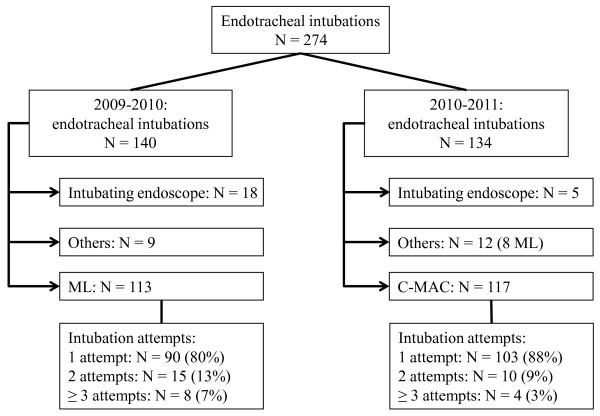
Flow chart of the prospective study. ML, Macintosh laryngoscopy.